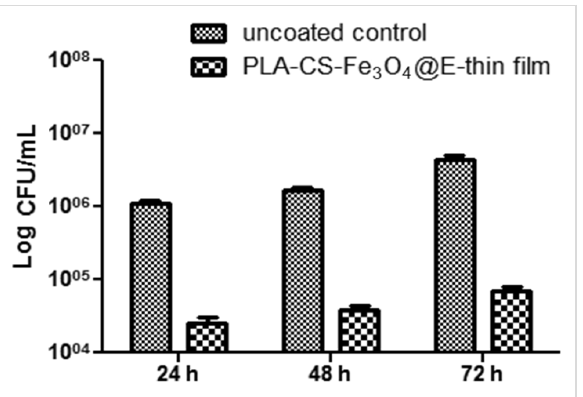
Figure 7: Graphic representation of viable cell count analysis after removal of S. aureus biofilm embedded cells 24 h, 48 h and 72 h post- infection (PLA-CS-Fe 3 O 4 @EUG thin film coatings vs uncoated control; CFU/mL = colony forming units/mL).